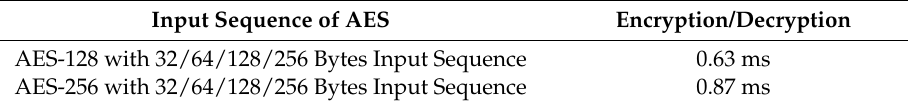
Table 4. The computation cost of AES implemented on the Arduino